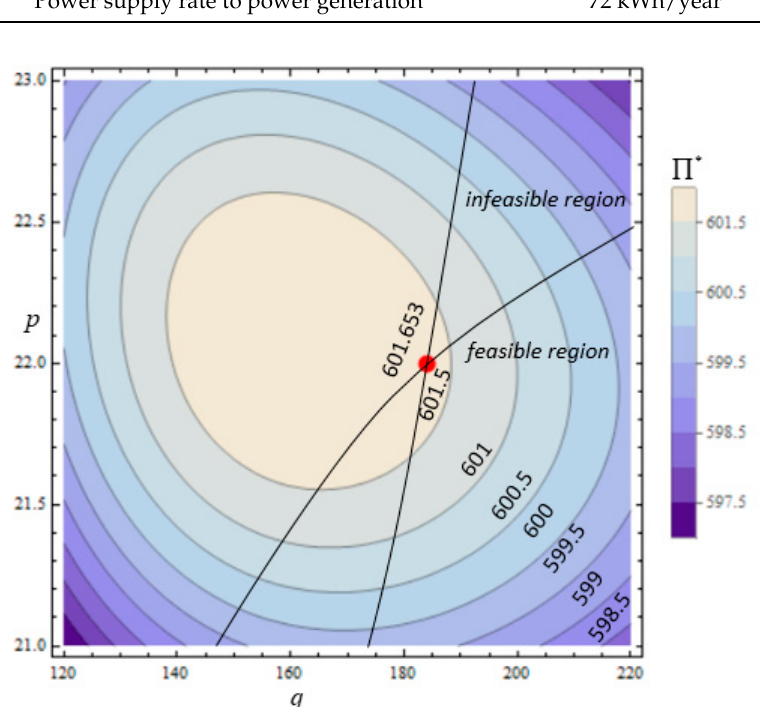
Figure 2. The contour of the objective function ∏ ∗ with respect to ζ = 2, η = 1, ρ = 1, I = 1.68236 and T =